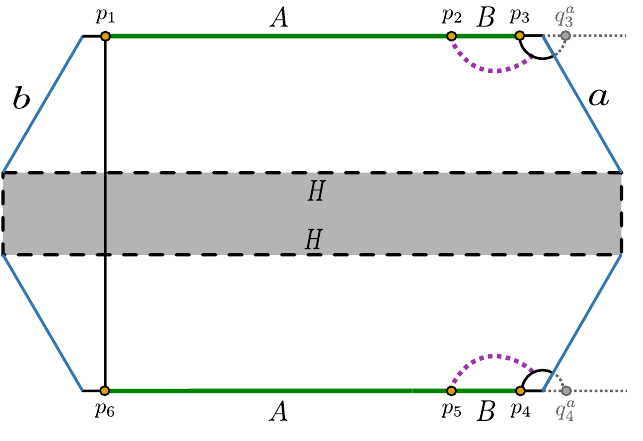
Figure 16 . The points in the two BCFT 2 copies are identified similarly as in figure 12.